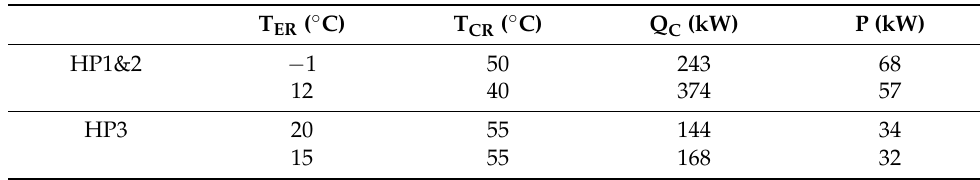
Table A7. Sample data from the